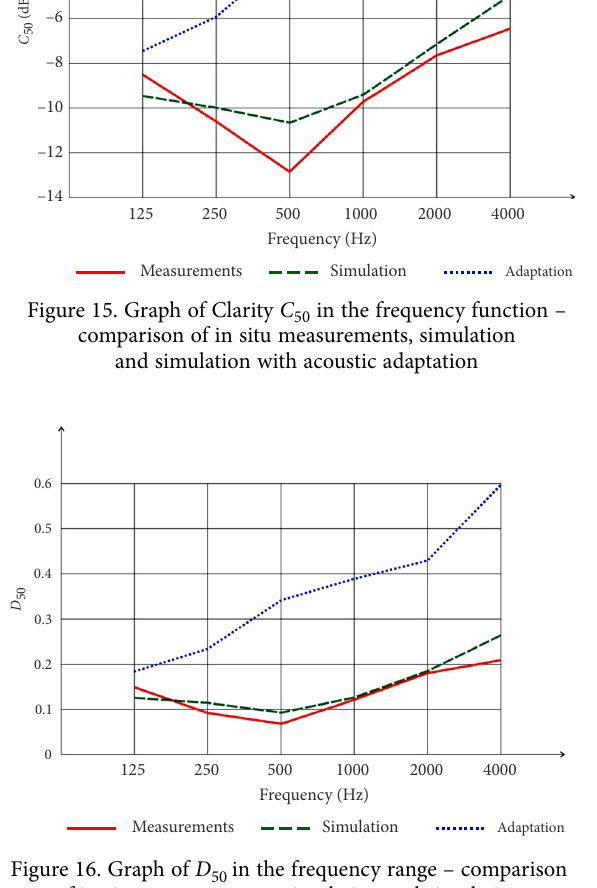
and simulation with acoustic treatment